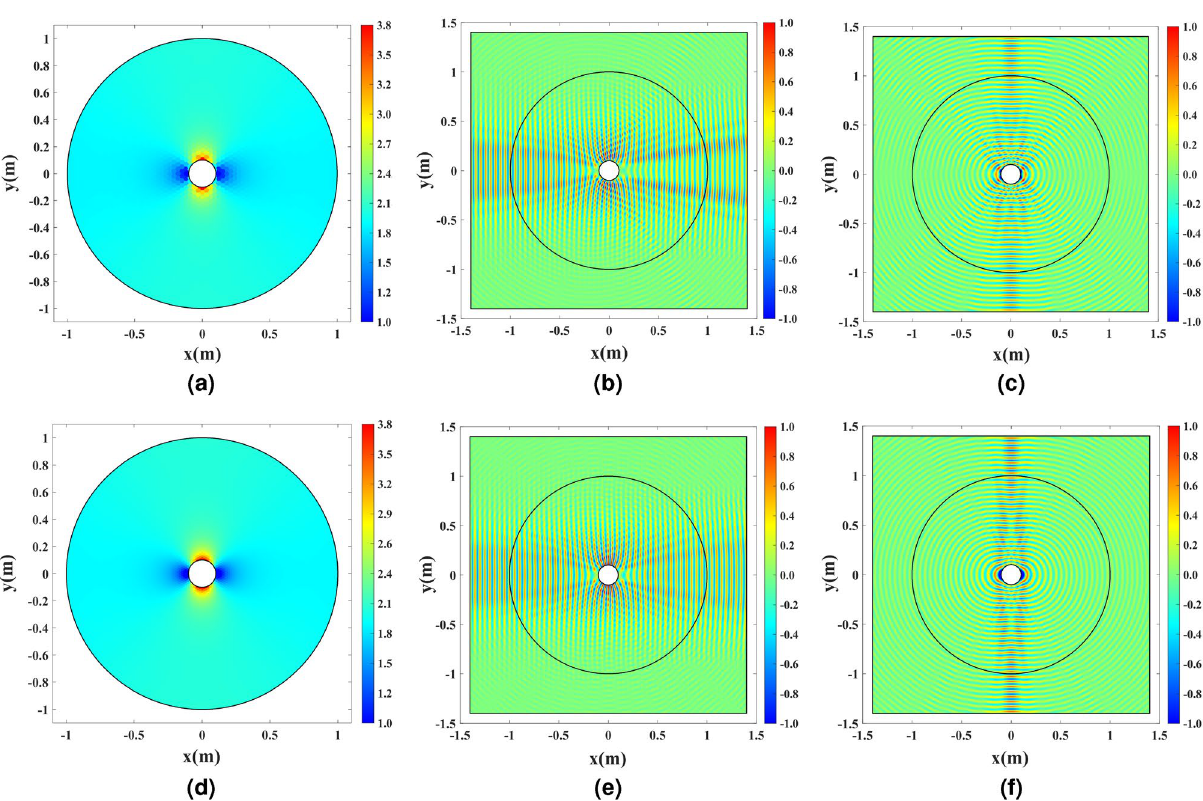
Figure 13. Full-wave simulation results for the cylindrical wire enclosed by the discretized refractive index. ( a ) Discretized refractive index profile, ( b ) the amplitude of H z for a TM Gaussian wave illuminating the structure, and ( c ) the amplitude of E z for the wire excited by the uniform electric current density J z at 3 GHz for L Cell = (cid:31) / 5 . ( d ) Discretized refractive index profile, ( e ) the amplitude of H z for a TM Gaussian wave illuminating the structure, and ( f ) the amplitude of E z for the wire excited by the uniform electric current density J z at 3 GHz for L Cell = (cid:31) / 10